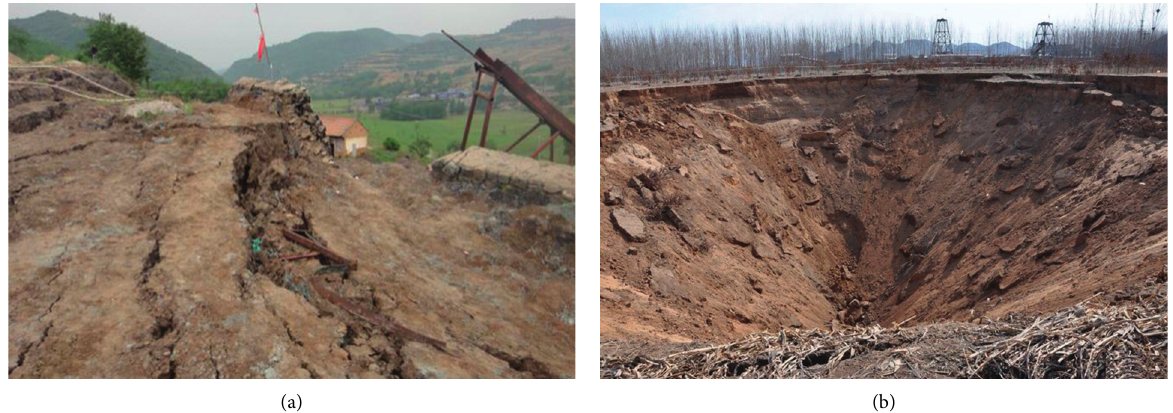
Figure 1: Photos of typical geological disaster caused by coal mining. (a) Landslides caused by coal mining. (b) Ground sinkhole caused by